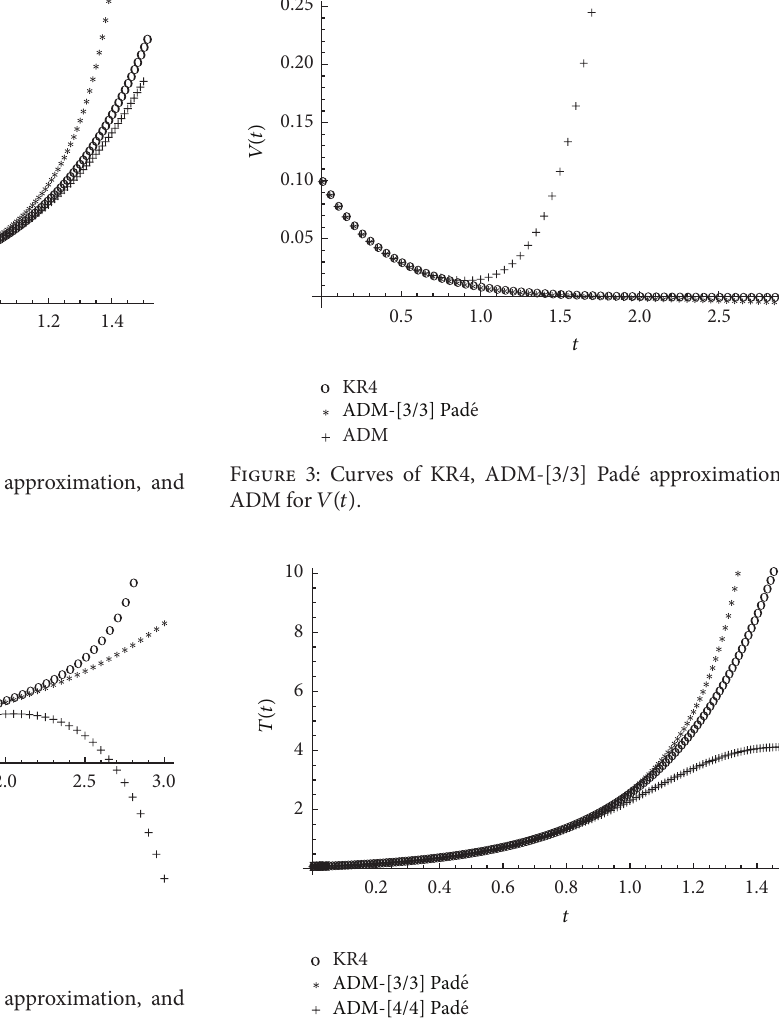
Figure 4: Curves of KR4 and ADM-[3/3] and ADM-[4/4] Pad´e approximations for 𝑇(𝑡)